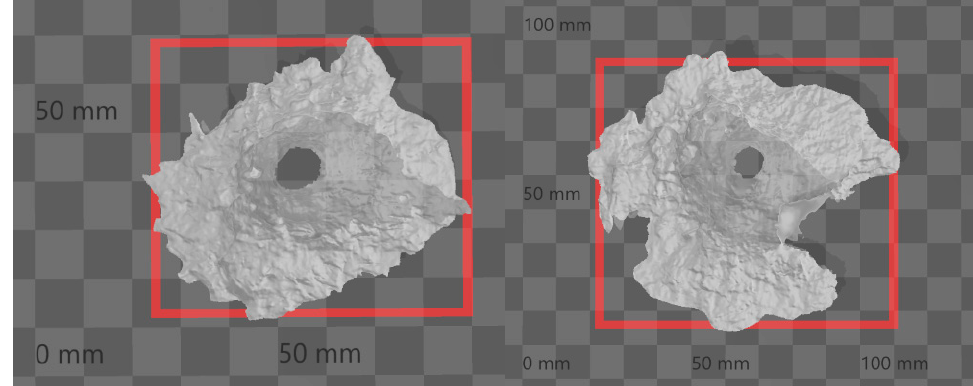
Figure 6. Three-dimensional scan of the crater. Left —entrance side, right —exit side.